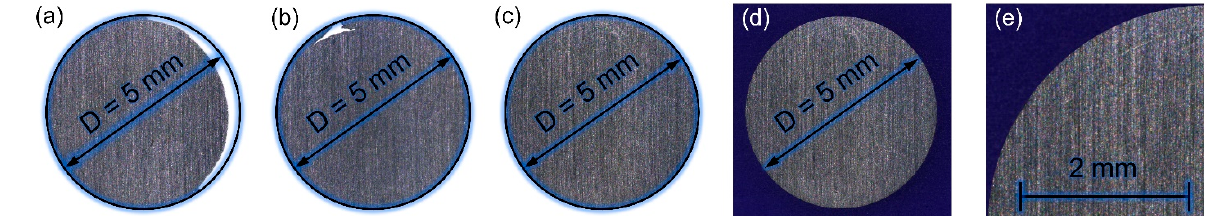
Figure 5. Dependence of semi-finished product quality on process time and temperature. ( a ) Extrusion after 420 s shows strong deviations from the ideal geometry. ( b ) After 600 s, only minor imperfections, ( c – e ). After 800 s, a good wire is extruded in terms of both die filling and surface quality.